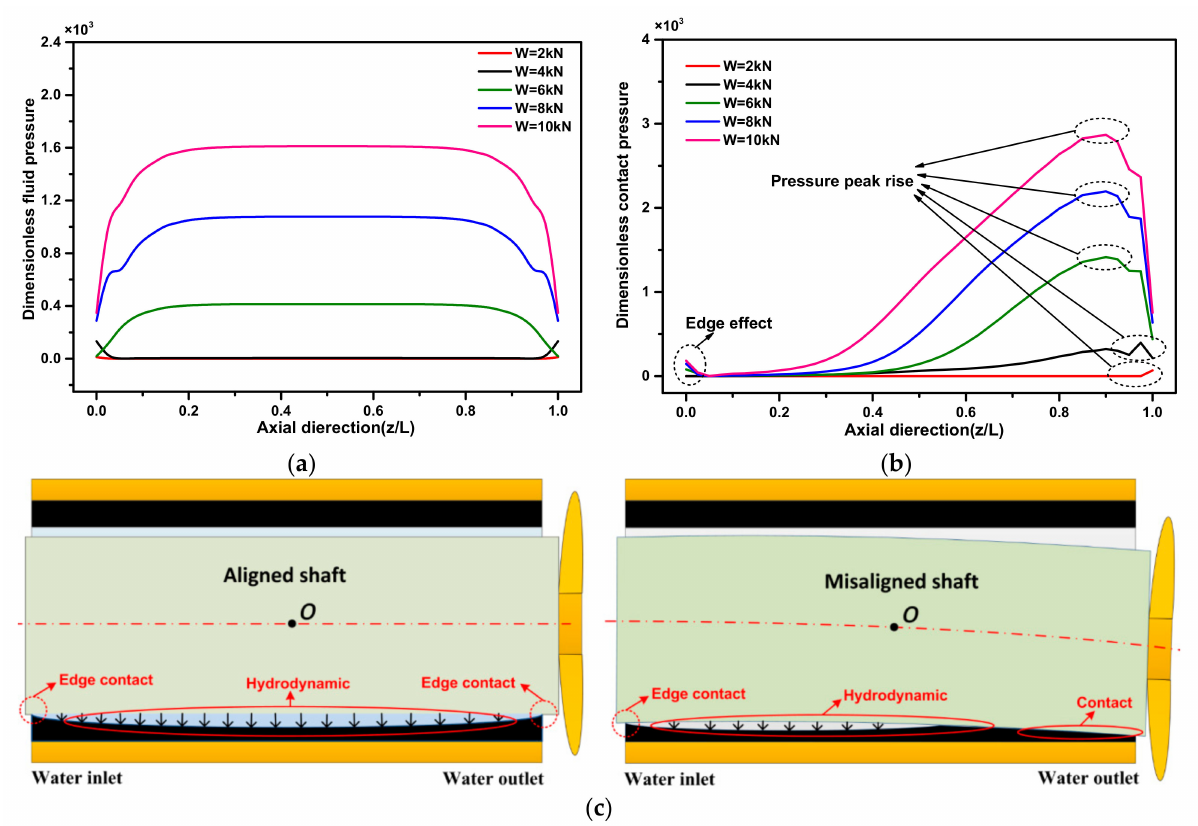
Figure 14. Distributions of contact pressure in the axial section obtained with the aligned shaft case and the misaligned shaft case, respectively: ( a ) water film pressure; ( b ) contact pressure; ( c ) edge effect of the aligned shaft and the misaligned shaft